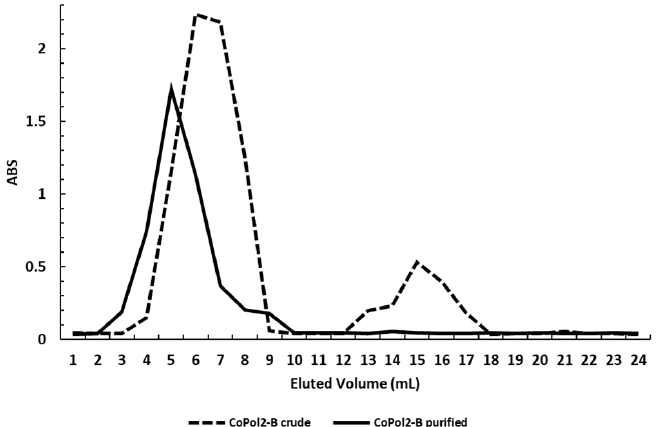
Figure 1. Elution of the copolymer P(MMA ‐ ran ‐ DMAEMA) linked to BODIPY (Table 2, entry 4), through a Sephadex LH 20 column, eluted with methanol. The first peak corresponds to the conjugate copolymer, the second fraction to the free BODIPY.